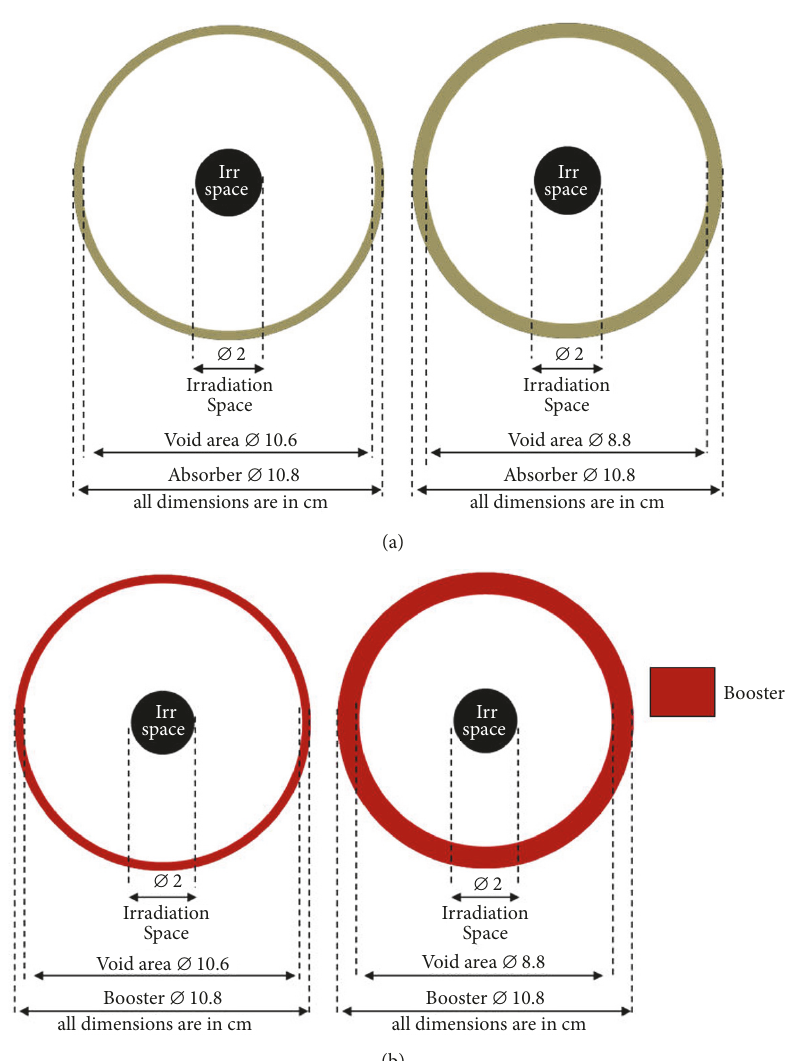
Figure 6: Irradiation device of two different thicknesses constituted by (a) absorbing material and (b) fissile material.